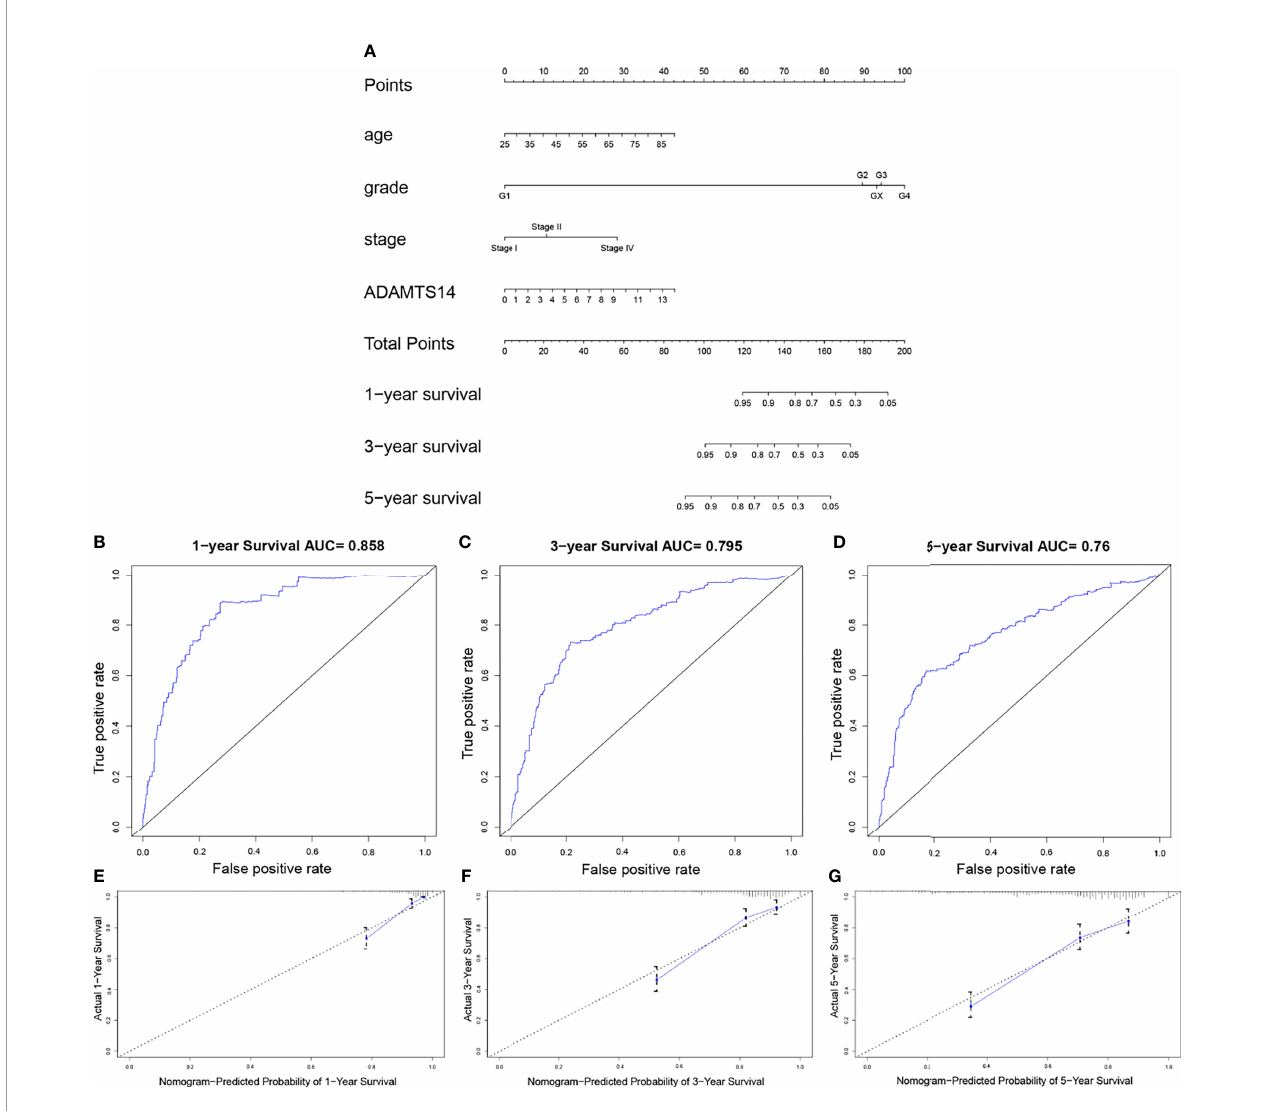
FIGURE 4 | Establishment of a prognostic prediction nomogram for ccRCC in TCGA dataset. (A) Nomogram for predicting 1-, 3-, and 5-year OS for ccRCC patients in TCGA. (B – D) One-, 3-, and 5-year ROC curves of the established nomogram. (E – G) One-, 3-, and 5-year calibration plots of the established nomogram.